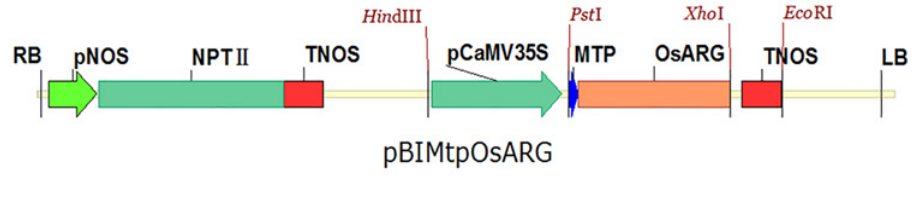
Fig 1. Map of the plant expression